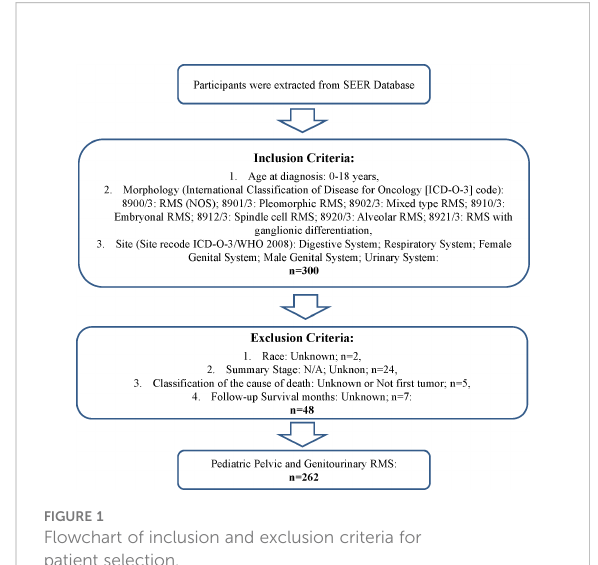
FIGURE 1 Flowchart of inclusion and exclusion criteria for patient